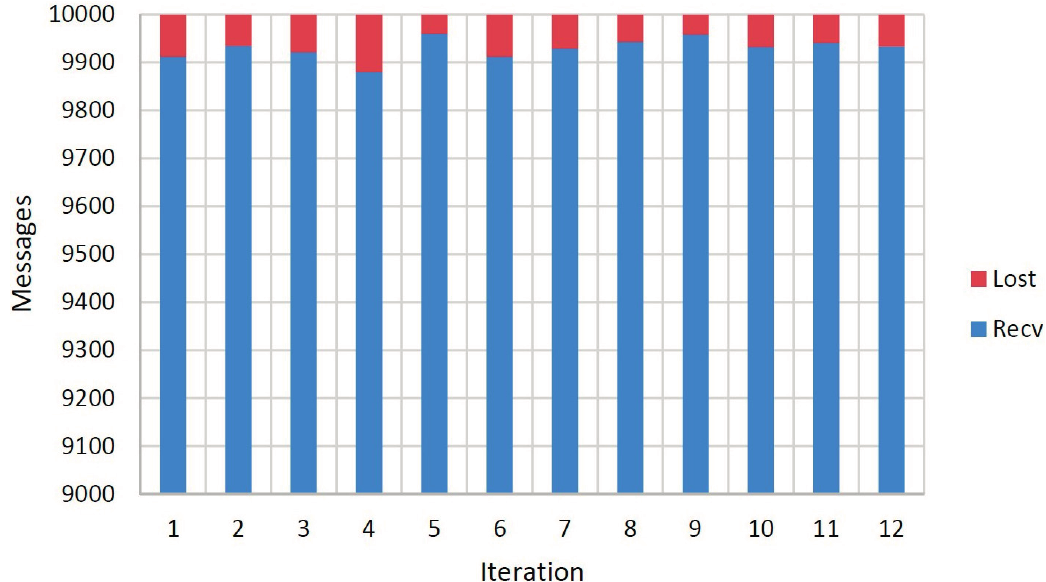
Figure 20. Messages received and lost during the experimentation.